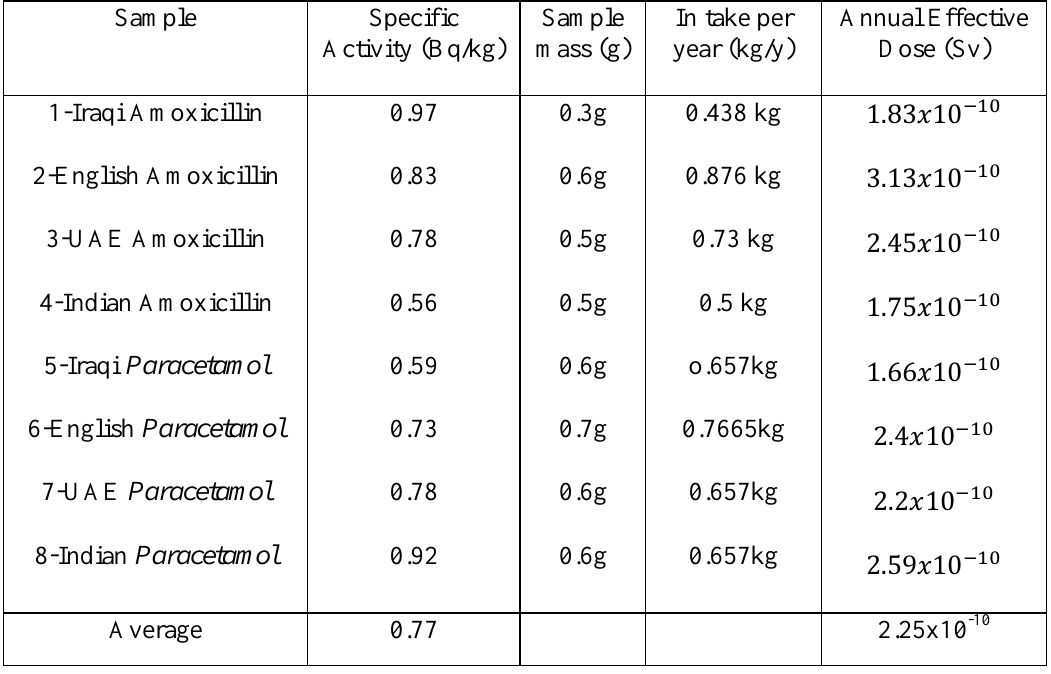
Table 4: Specific activity, sample mass, in take mass per year and annual effective dose of 228 Ac for all